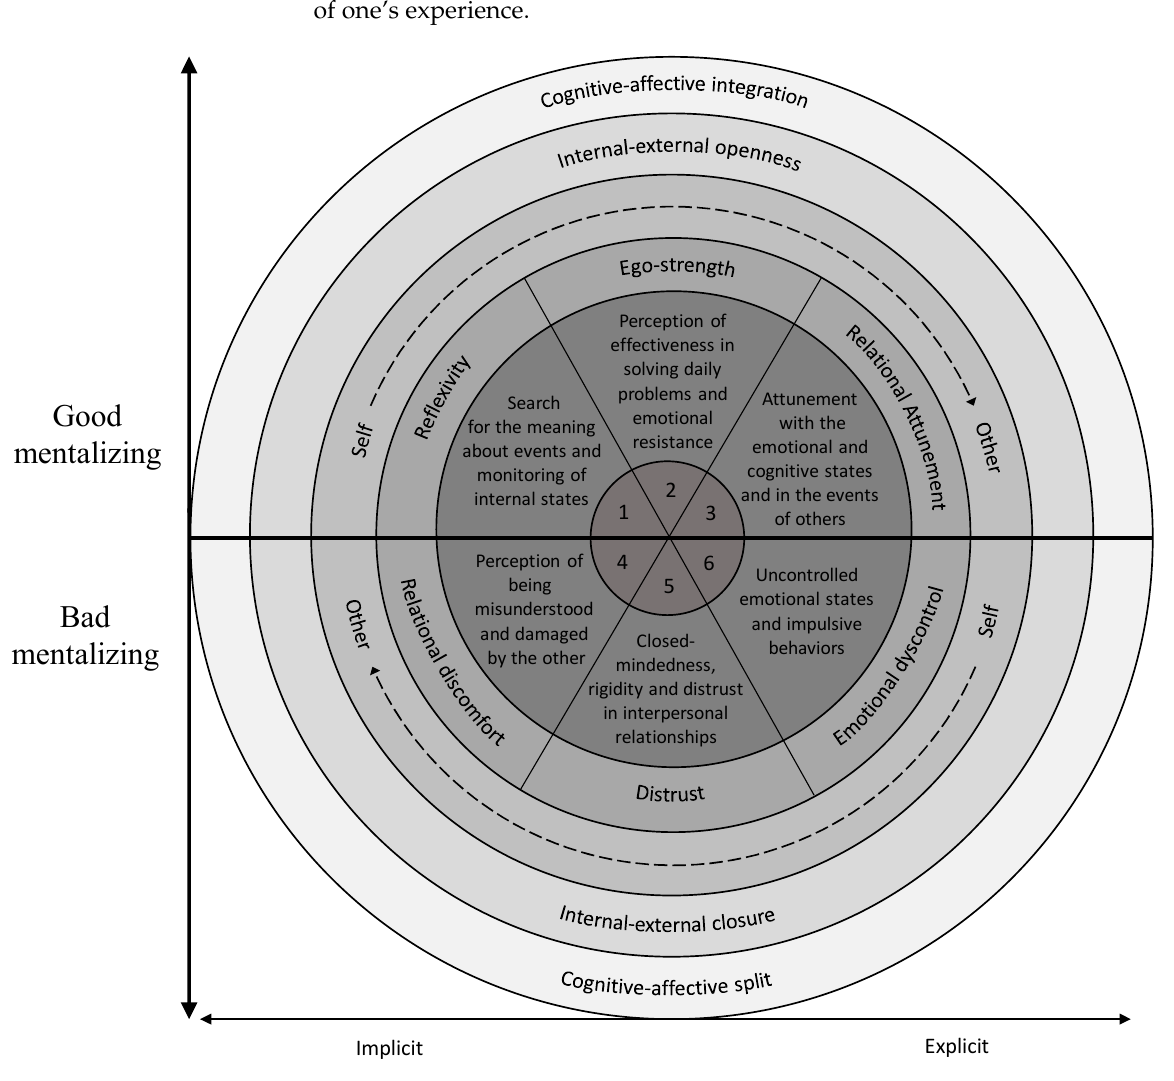
Figure 1. The integrated and multilevel model of mentalizing. Note: Reproduced from Gori and colleagues [29].